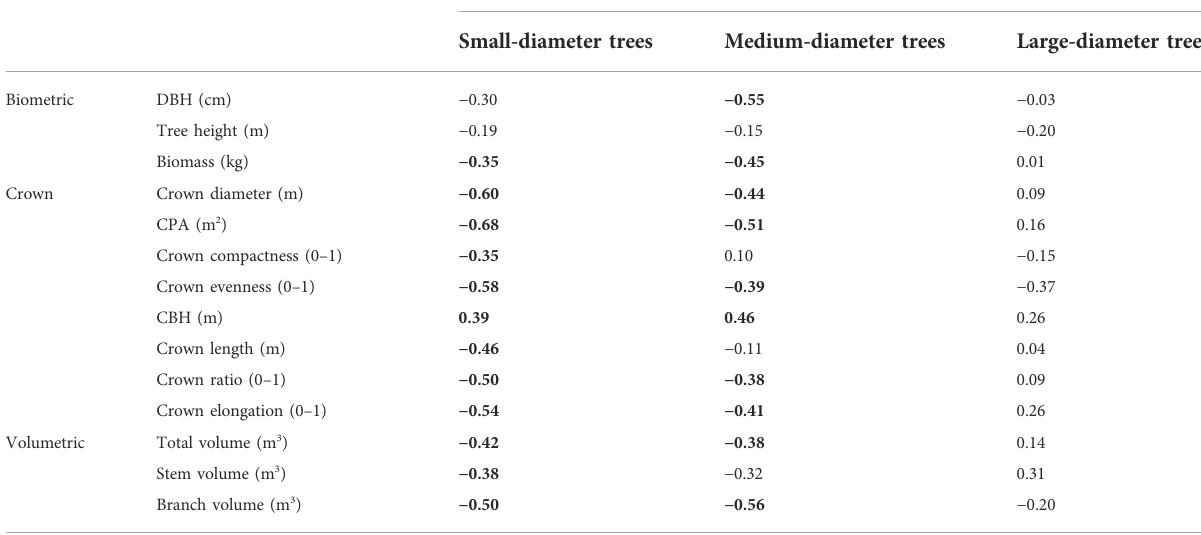
TABLE 4 Spearman ’ s rank correlation coef fi cients (R) between crownscorch(%) andeachpost- fi re tree attribute among small-, medium-,and large- diameter trees (signi fi cant correlations ( p < 0.05) are highlighted in bold).